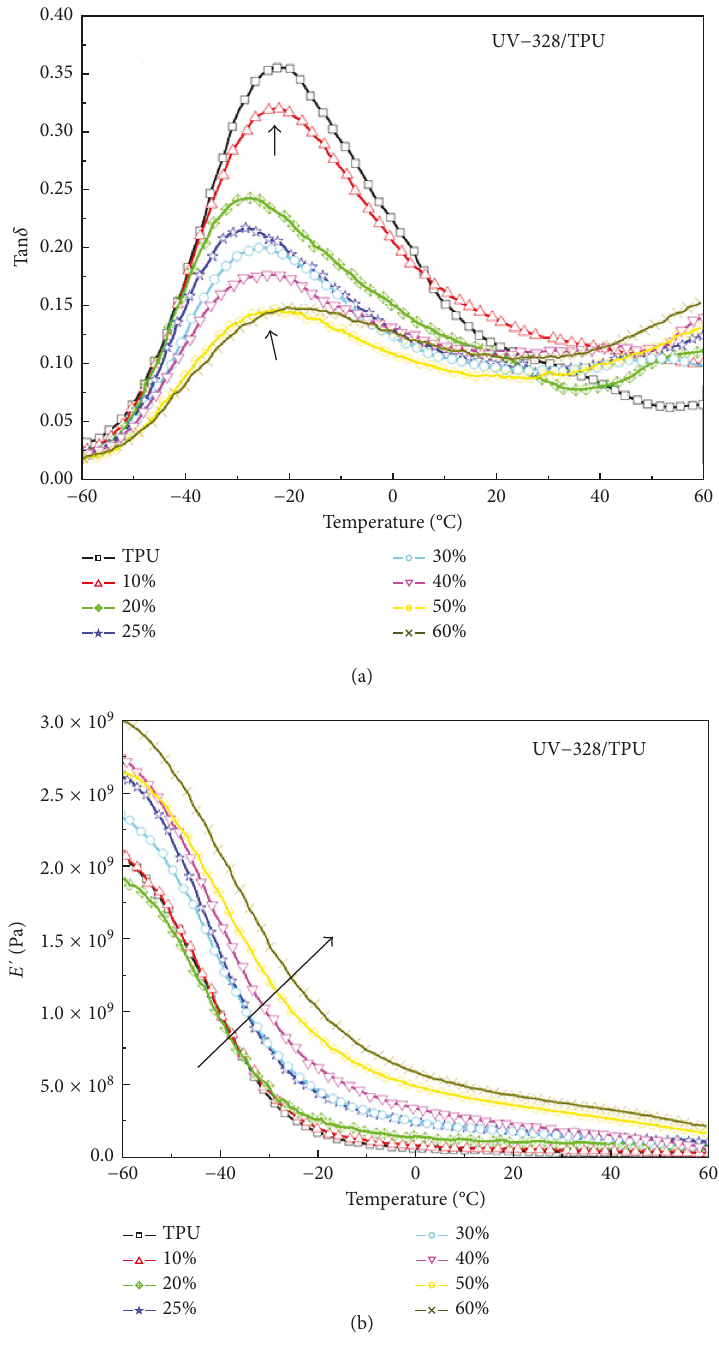
Figure 5: Temperature dependence of (a) tan δ and (b) E